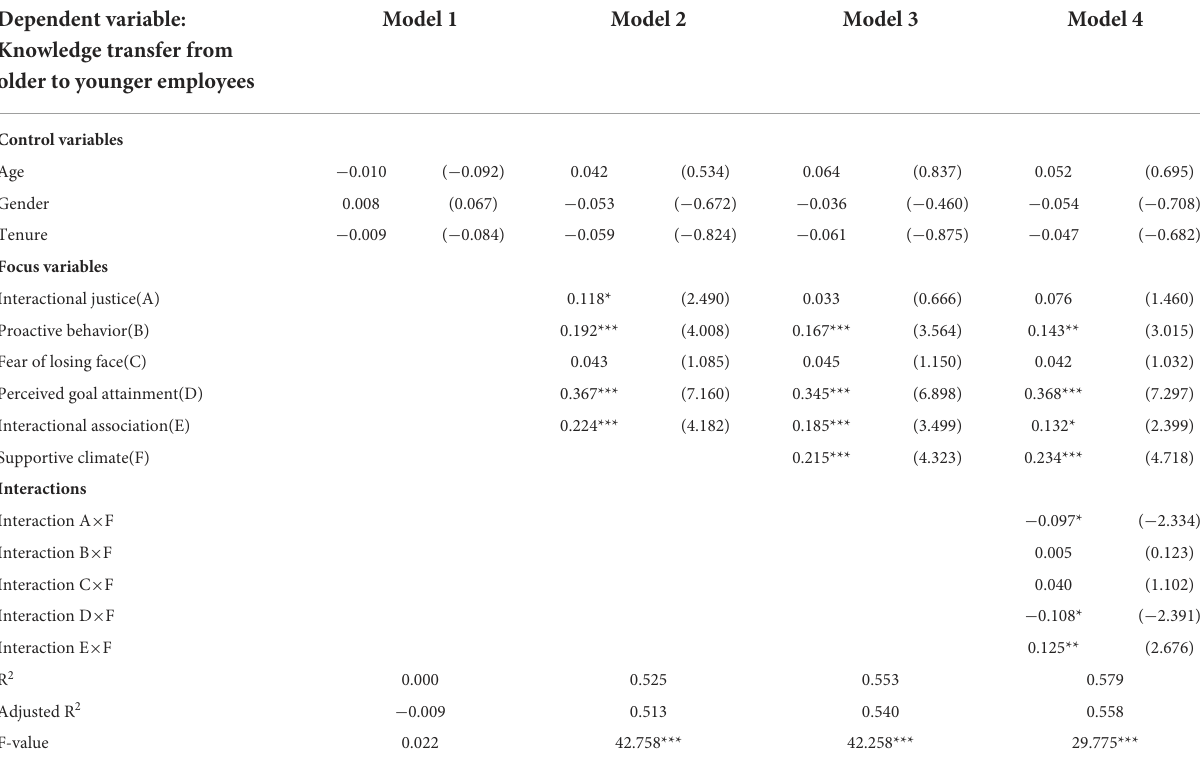
TABLE 5 Results of the hierarchical linear regression